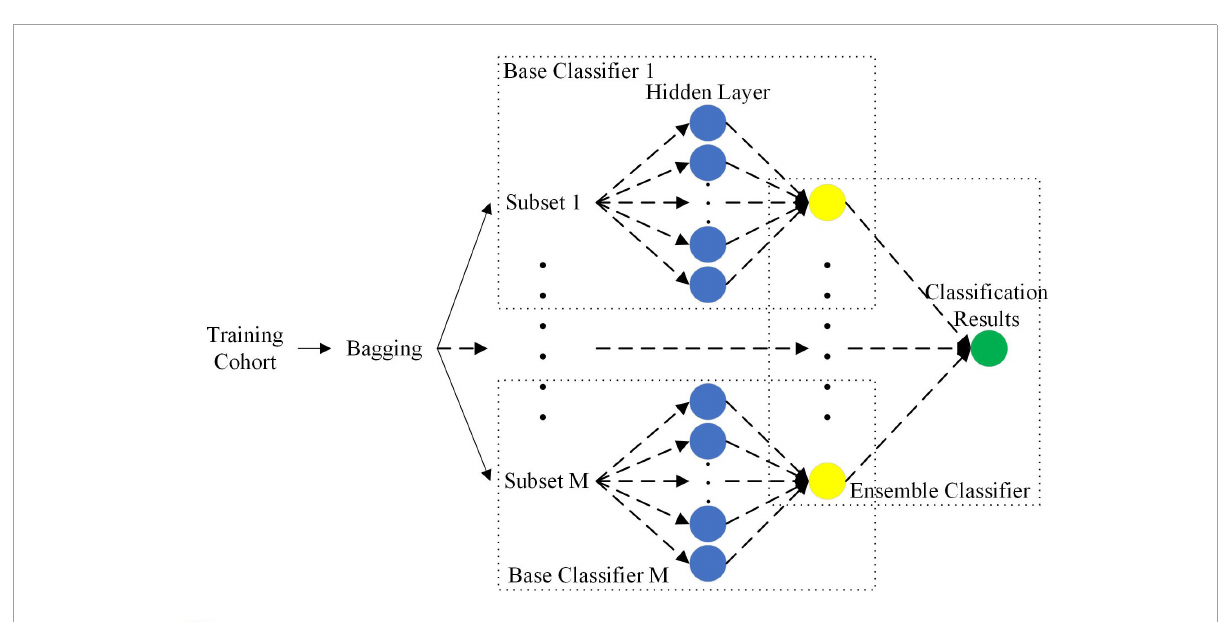
a hyperparameter vector α = ( α i , · ·· α D ) T , which is the diagonal element of the w covariance matrix. Due to the conjugation of the Gaussian prior to the Gaussian